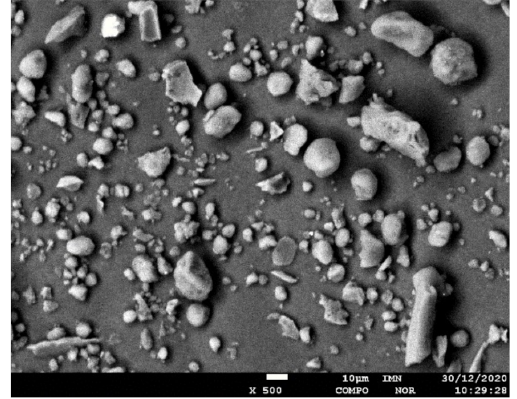
Figure 6. COMPO microscopic picture of the analyzed activated carbon; zoom 500 × .